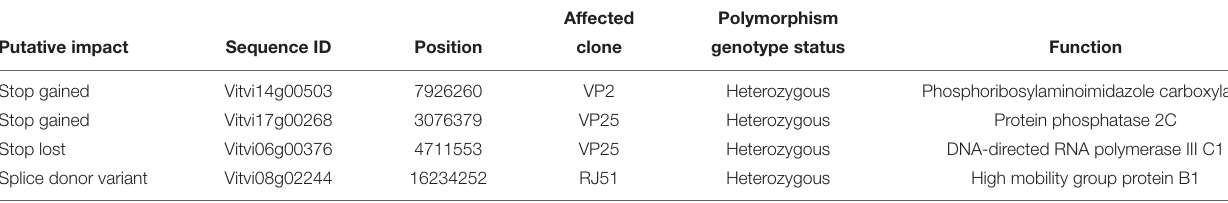
TABLE 3 | Detected SNP and indels with a predicted high impact on the protein structure.